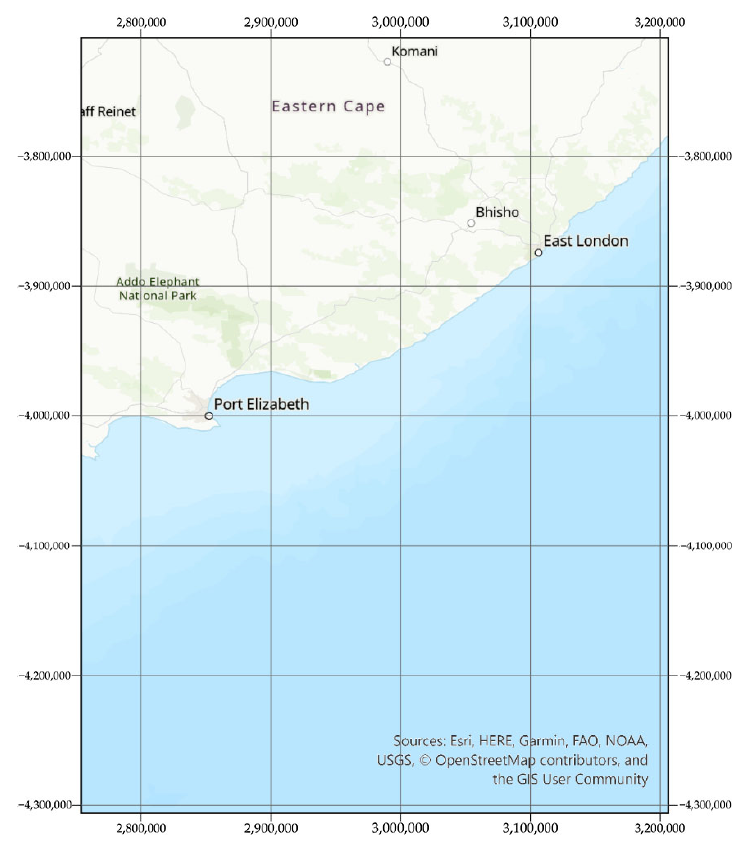
Figure 8. Study area: water of South Africa.